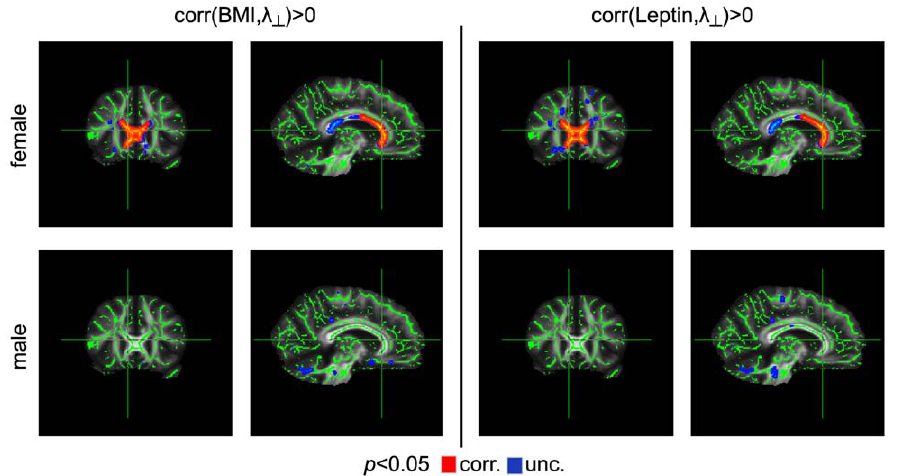
Figure 4. Correlation between l H and body weight using BMI (left) and leptin levels (right). For women, we found a significant positive correlation between BMI and l H in the corpus callosum (top row). For men, we found no dependency between BMI and radial diffusivity even without correction for multiple comparisons (bottom row). The same results were obtained for the leptin level instead of BMI (see right columns).